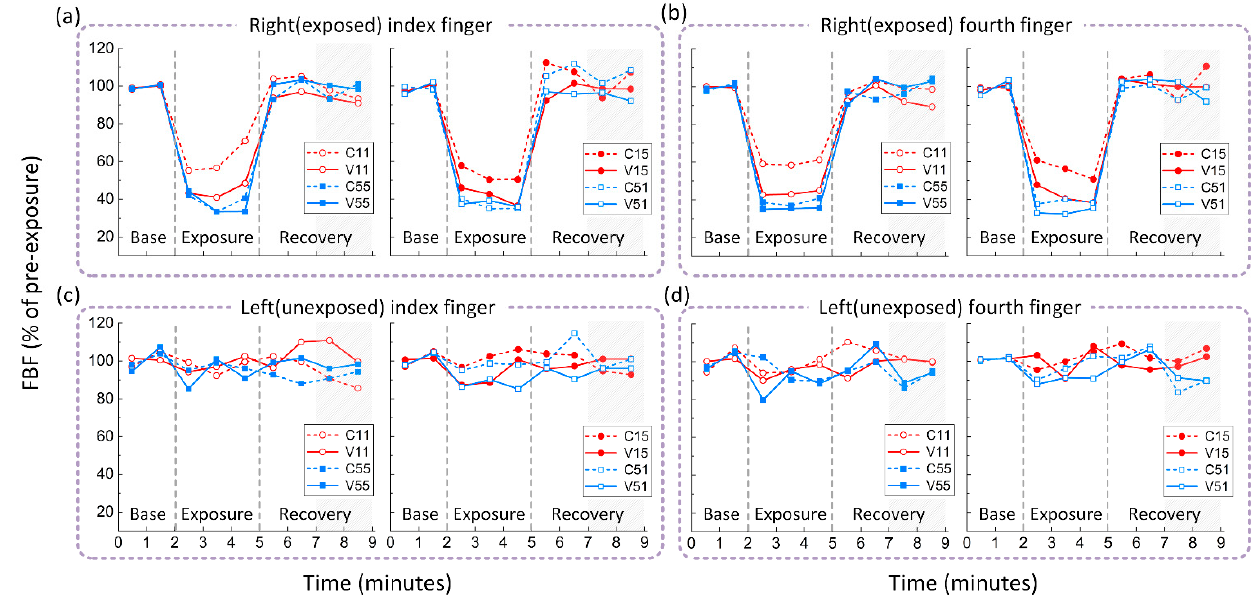
Figure 3. Percentage change of finger blood flow (% of pre-exposure) in the ( a ) index and ( b ) fourth right fingers (R2, R4, ipsilateral to hand force and vibration), and the ( c ) index and ( d ) fourth left fingers (L2, L4, contralateral) during the eight exposure conditions (see Table 1). The resting period of each following round was considered as the latter part of the recovery period of the previous round. The two dashed lines correspond to the time points at which exposure begun and ended, respectively. Plotted symbols are median values.